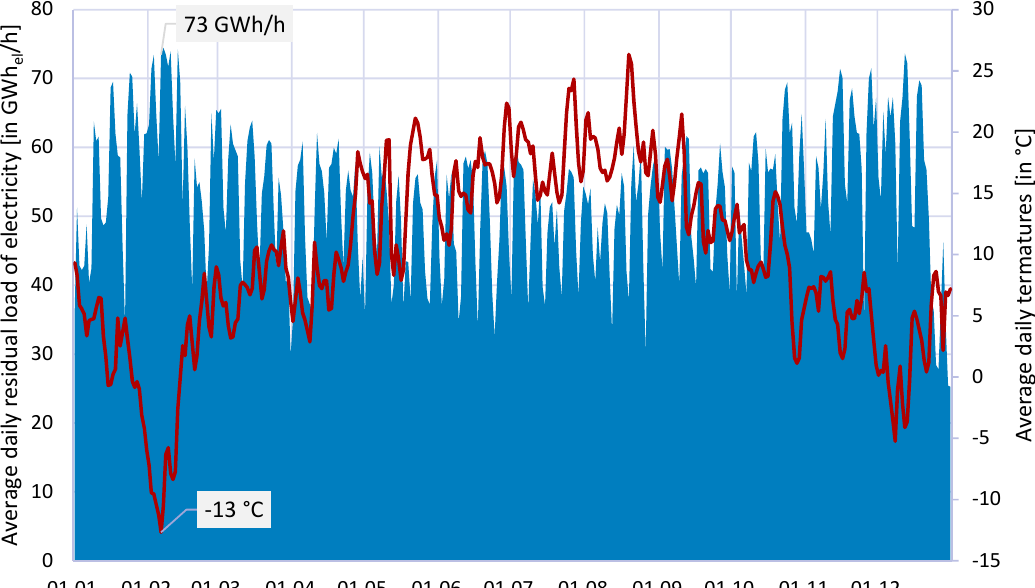
Figure 1. Temperature and electrical residual load profiles in 2012. Source: authors’ illustration based on [5 – 7].